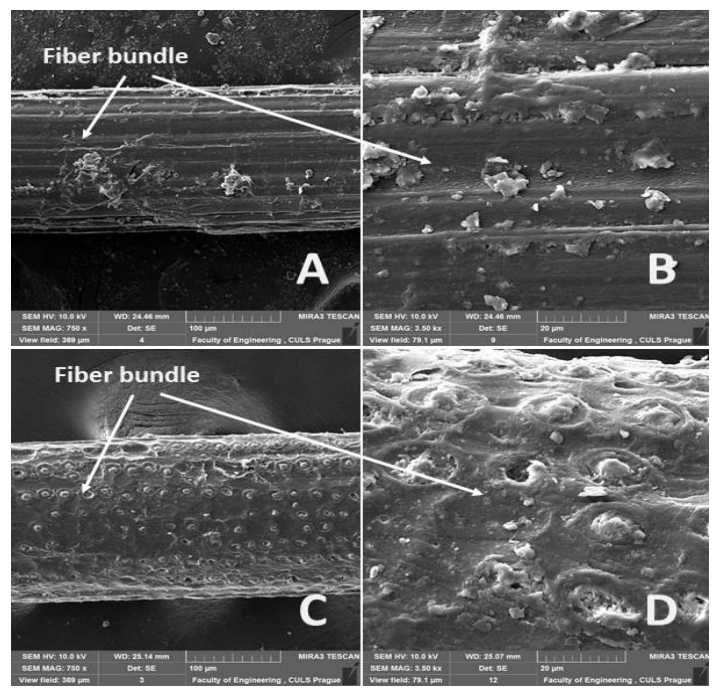
Figure 6. SEM images of the surfaces of abaca and coir fibers without treatment in a 5% solution of NaOH ( A ): Abaca fiber bundle (MAG 750 x) ( B) : detailed view of the surface of an abaca fiber (MAG 3.50 kx), ( C ): coir bundle (MAG 750 x), ( D ): detailed view of the surface of a coir fiber (MAG 3.50 kx).